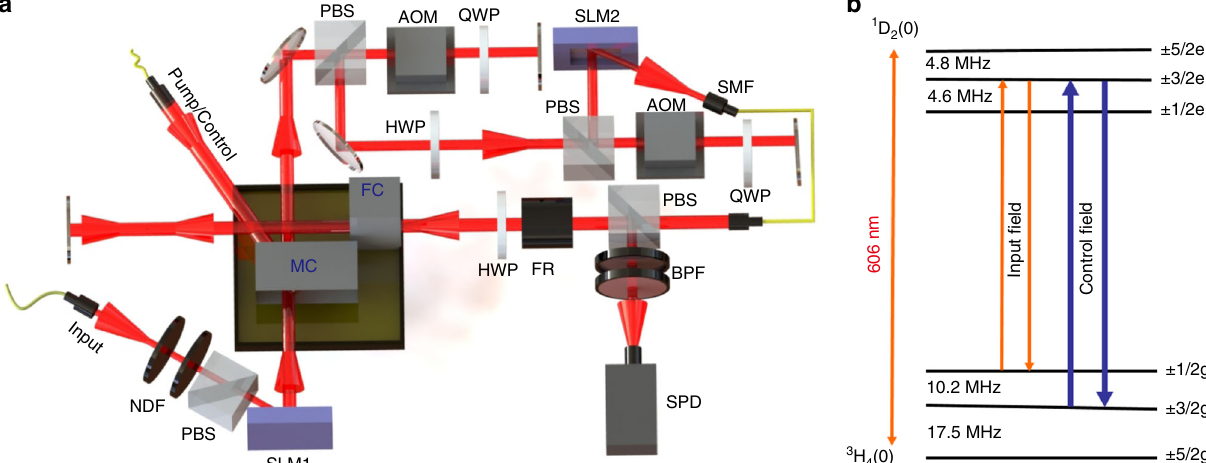
Fig. 1 Experimental setup and atomic levels. a Schematic illustrations of the experiment. The AFC is prepared in a memory crystal (MC) and a narrow spectral fi lter has been prepared in a fi lter crystal (FC) 49 . The beam waist of the input light is 65 μ m at the middle of the MC. The pump/control light has a beam waist of 300 μ m inside the MC to ensure good overlap with the high-dimensional input light. The input pulses are attenuated to single-photon level by neutral density fi lters (NDF). The spatial modes of these photons are converted into OAM superposition states by a spatial light modulator (SLM1). After storage in the MC, the retrieved signal passes through two consecutive acousto-optical modulators (AOM) 42 , which act as a temporal gate and a frequency shifter. The AOM are used in double-pass con fi guration to ensure the photons ’ spatial mode unchanged when the frequency of photons is swept over tens of MHz. The SLM2 and a single-mode fi ber (SMF) are employed to analyze the OAM states of the retrieved photons. The FC is double-passed with help of a polarization beam splitter (PBS), a half-wave plate (HWP) and a Faraday rotator (FR). Two bandpass fi lters (BPF) centered at 606 nm are employed to further suppress noises before the fi nal detection of signal photons using single-photon detector (SPD). QWP quarter-wave plate. b Hyper fi ne states of the fi rst sublevels of the ground and the excited states of Pr 3 + in Y 2 SiO 5 . The input fi eld is resonant with 1/2g – 3/2e, and the control fi eld is resonant with 3/2g – 3/2e (see Methods section for